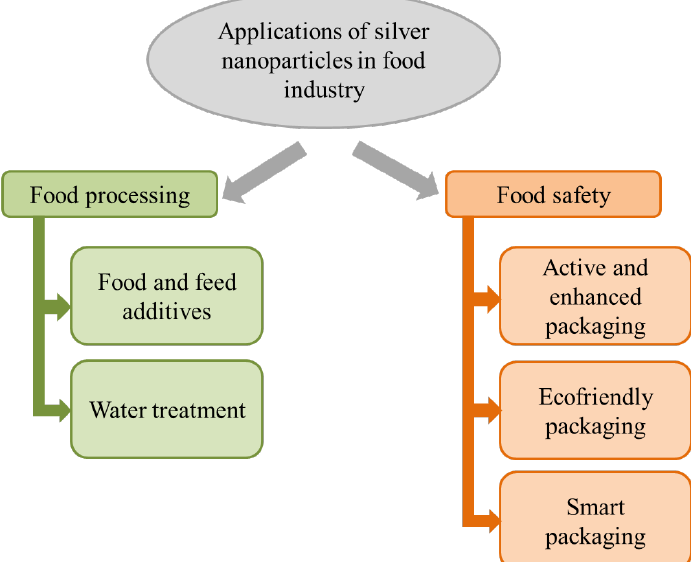
Figure 2. Classification of the use of Ag-NPs as antimicrobials in the food industry (adapted from Singh et al. [39]).